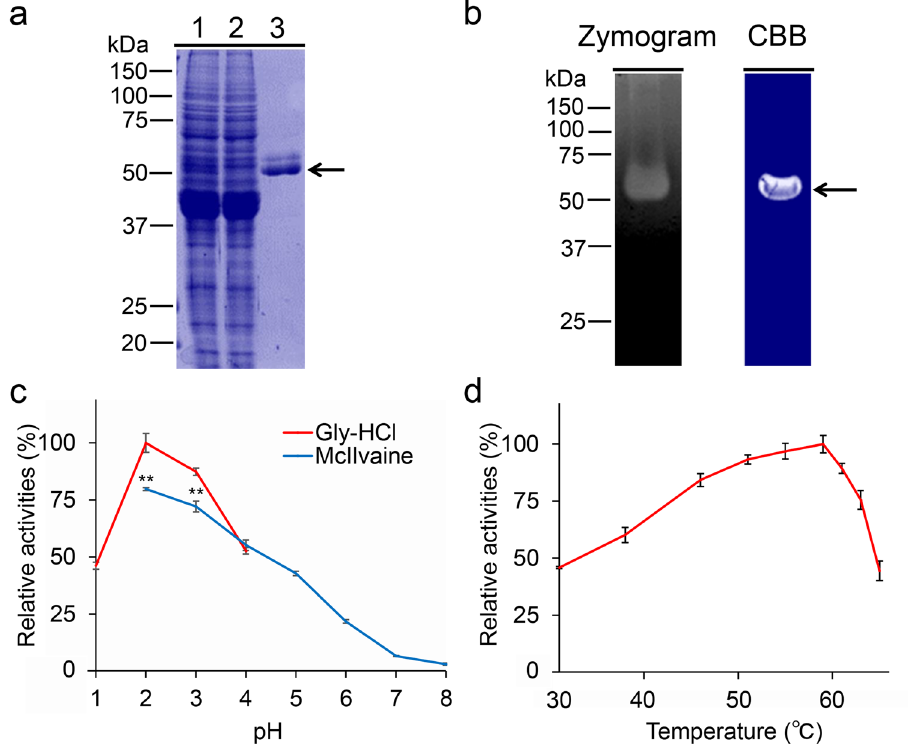
Figure 2. Purification and characterization of Chia from chicken glandular stomach. ( a ) Chia was purified from chicken glandular stomach tissues using chitin beads chromatography as described in Methods and analyzed by SDS-PAGE and visualized by Coomassie Brilliant Blue (CBB) staining. 1, extract; 2, flow- through; 3, purified enzyme. Purified Chia (1 μ g of protein) was electrophoresed and visualized in the gel by CBB. ( b ) Zymogram of chicken Chia. After electrophoresis, the gel was analyzed by Zymography (left), followed by CBB staining (right). Zymography was performed as described in Methods. ( c ) Optimal pH and ( d ) optimal temperature for Chia activity. Values in ( c , d ) represent mean ± SD conducted in triplicate. ** p < 0 . 01 . P-values were determined using Student’s